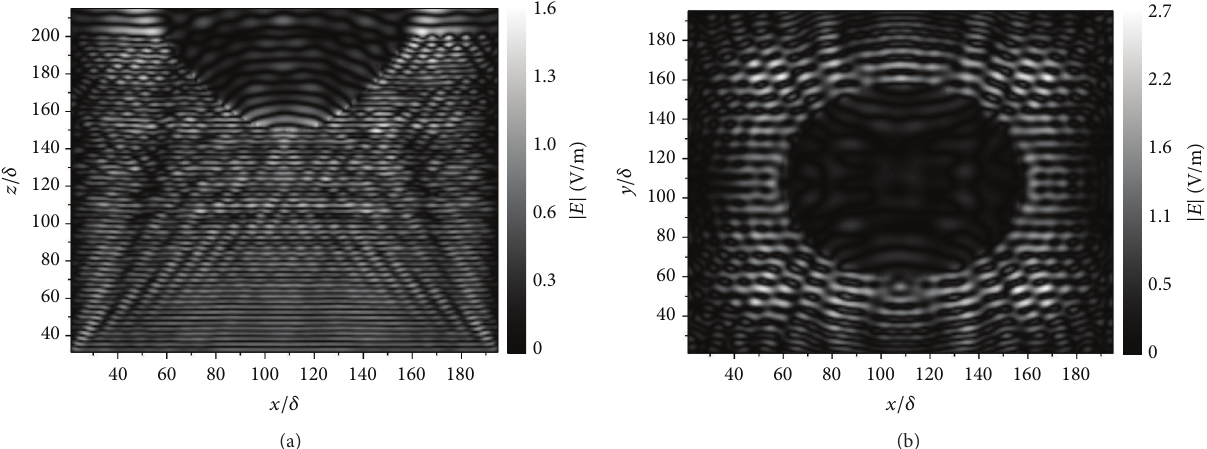
Figure 6: Electric field amplitude distributions when 𝑎 = 100𝛿 and Rcr = 0.5 : (a) Plane xoz and (b) Plane z 198 where the maximum electric field amplitude